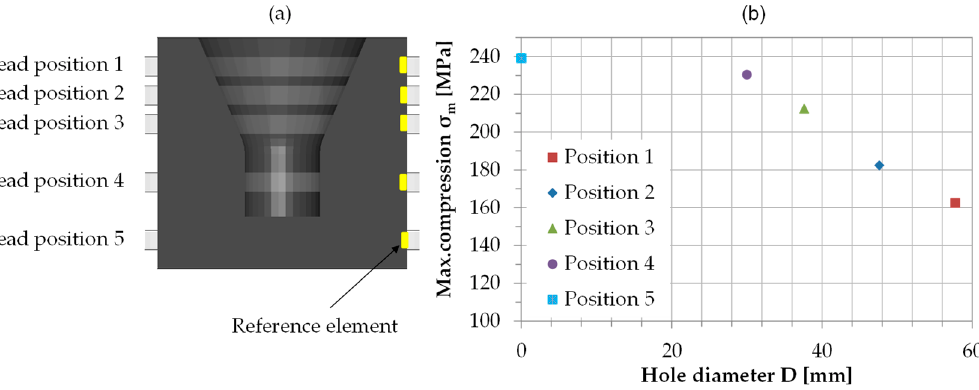
Figure 22. Different positions of a single bead on the tool surface (one bead in one numerical model) ( a ) and Influence of inner hole diameter D on the maximum compressive stresses on the tool’s surface ( b ).